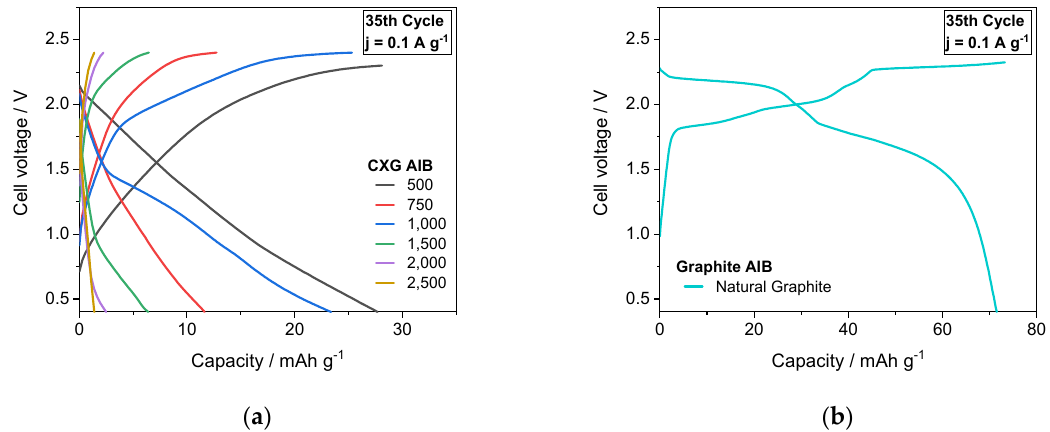
Figure 9. Charging and discharging curves of AIBs equipped with CXG 500–2500 ( a ) and natural graphite for comparison ( b ).